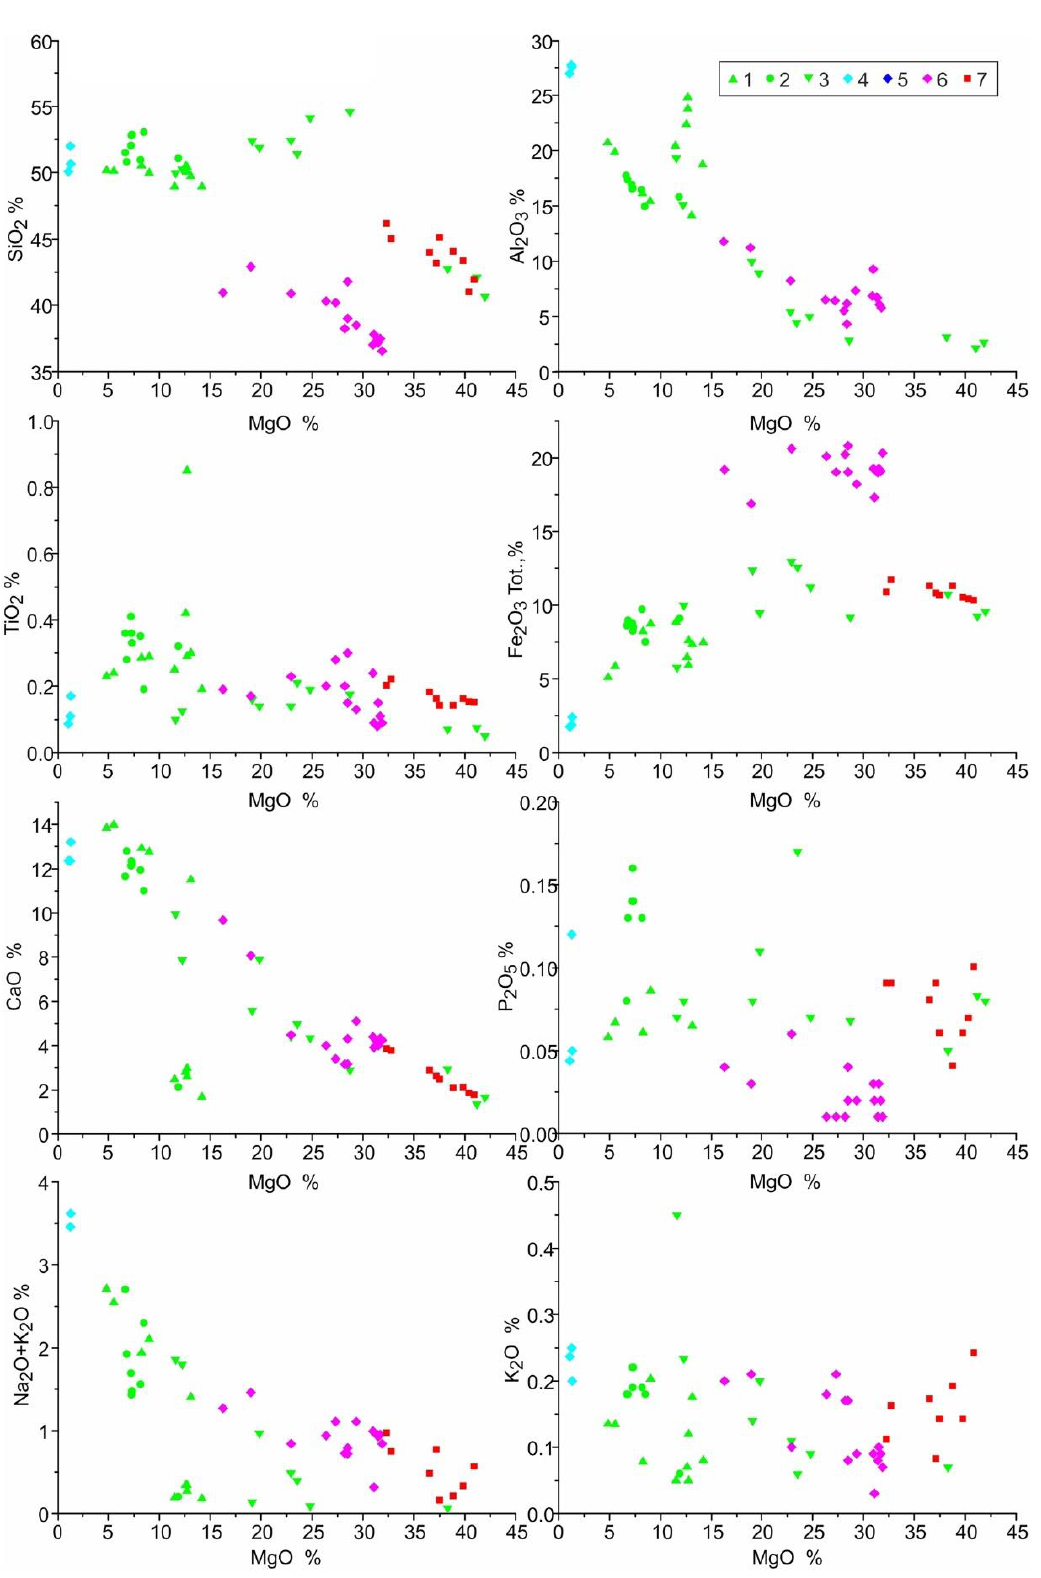
Figure 11. Petrochemical diagrams of MgO oxides in rocks of the massifs of Monchetundra, Chunatundra, and Volchetundra; harrisite; and intrusive body. 1: Rocks of the Upper, 2: Middle, and 3: Lower Zones of the Monchetundra massif; 4: Rocks of the massifs of Chunatundra and 5: Volchetundra; 6: Harrisite; 7: Rocks of the intrusive body (M-1 borehole).